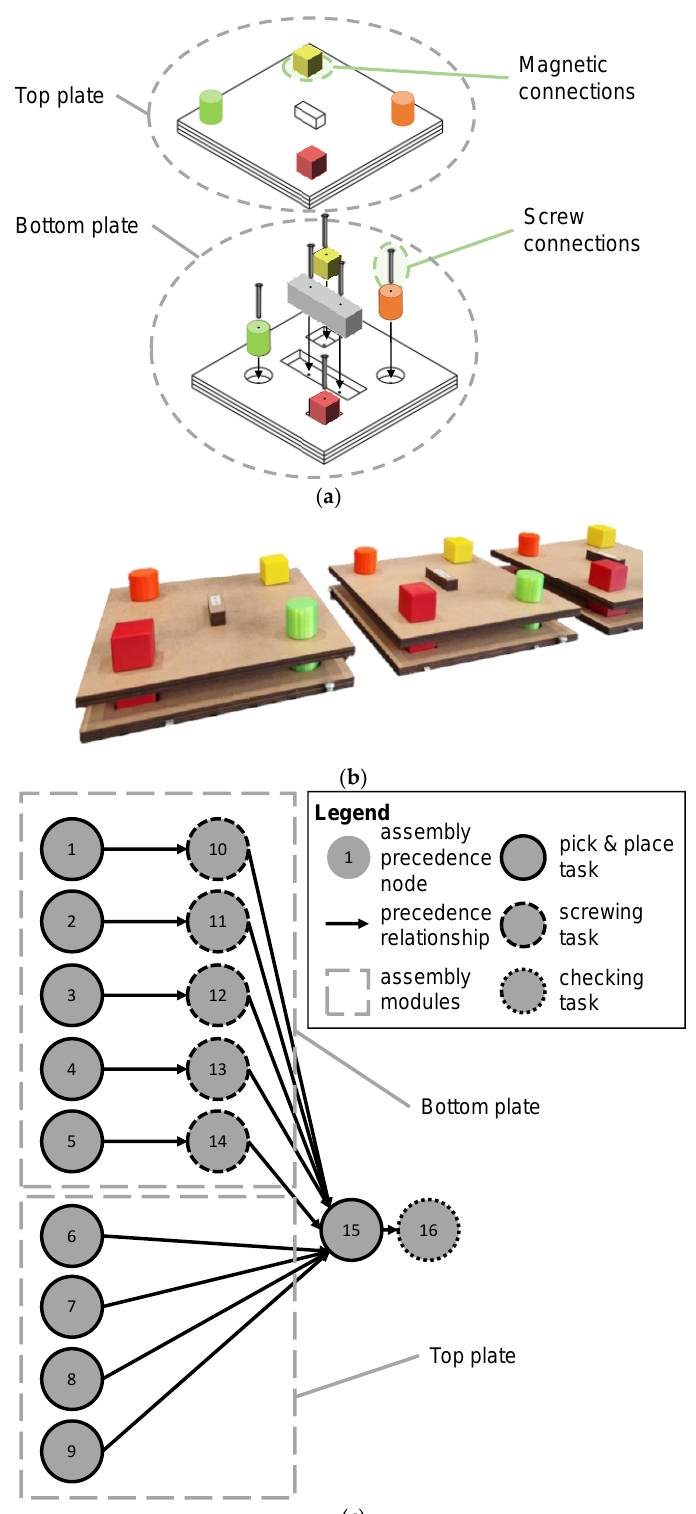
Figure 13. Assembly component for user study: ( a ) exploded view; ( b ) assembled real components; ( c ) assembly precedence graph for one assembly component.